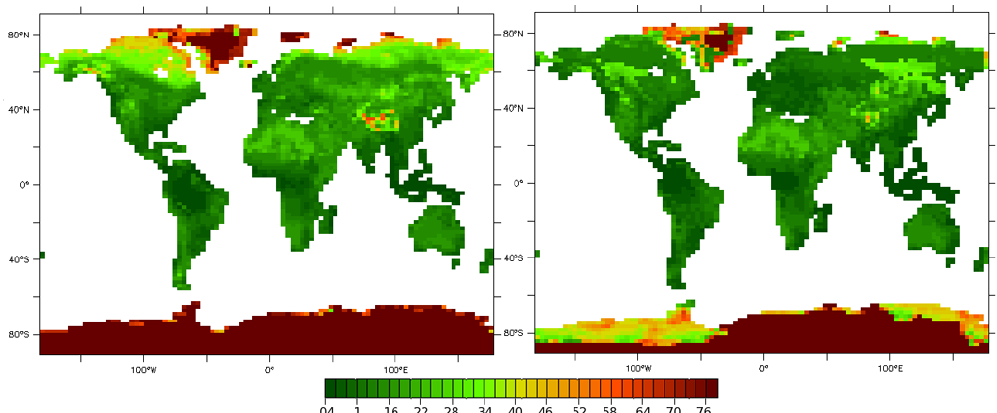
Fig. 5. Land surface albedo for the Control (left) and the mid-Pliocene (right) experiments, on the alternate land-sea mask, for every grid cell where land fraction or land ice fraction is superior to zero.